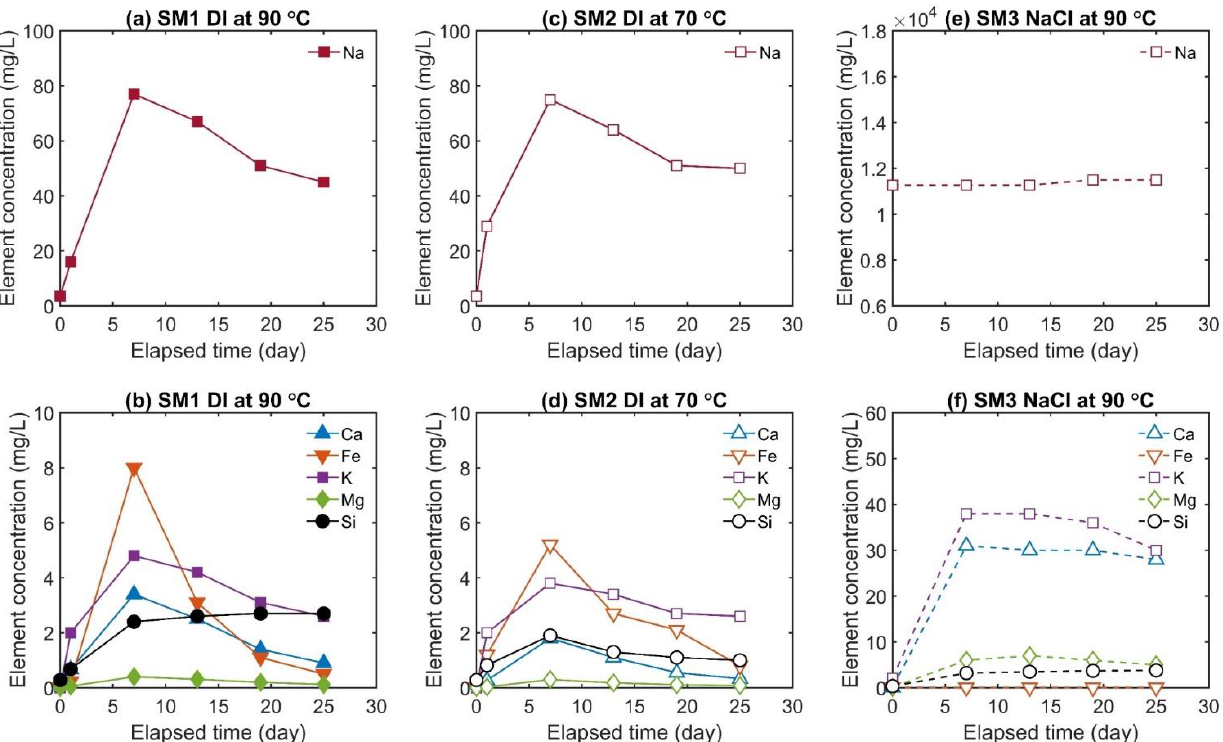
Figure 7. Peak effluent element concentrations extracted from each set of subsamples of sample SM1 ( a , b ), SM2 ( c , d ), SM3 ( e , f ), after prescribed time intervals. The data on day zero present the element concentrations of the injected fluid and data on day 1 (for SM1 and SM2) indicate the effluent sampled right after increasing the temperature to the targets. Note the different scales of Na concentrations.